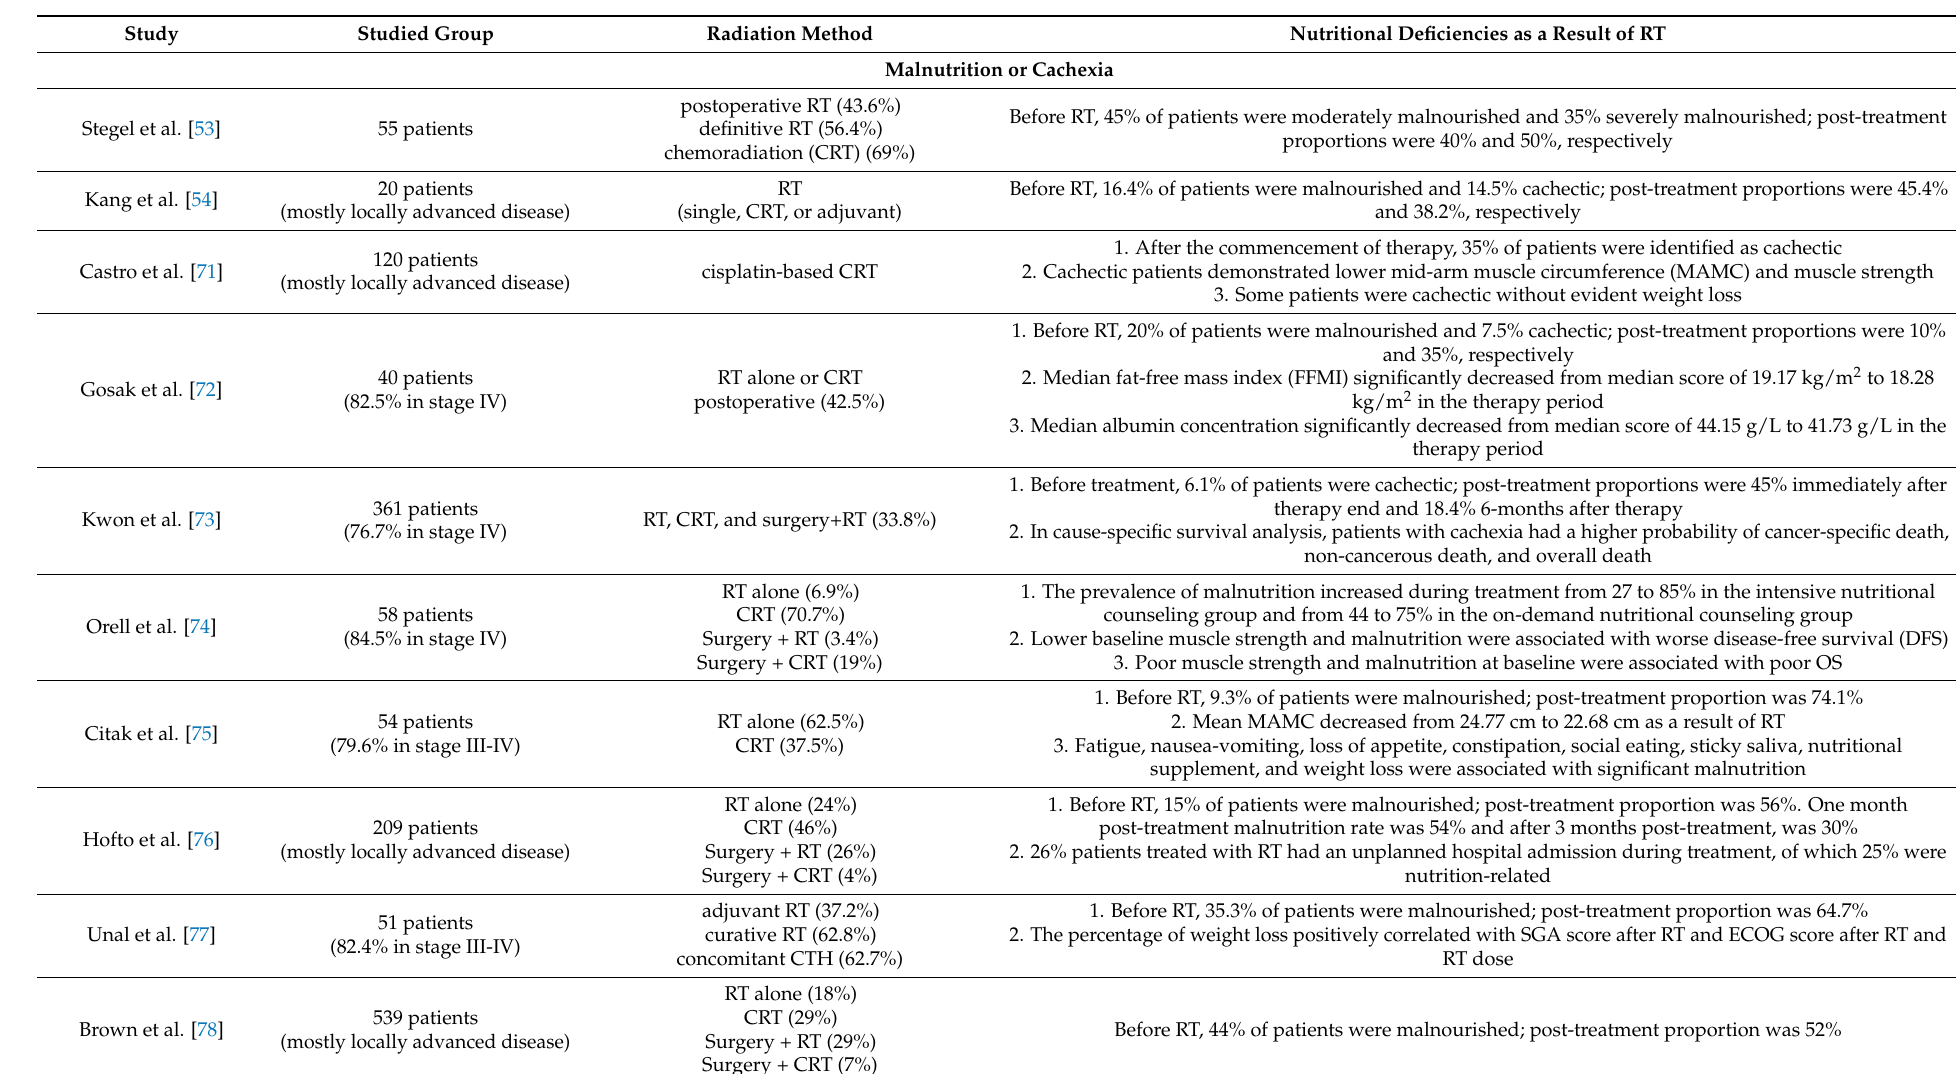
Table 2. Nutritional deficiencies developing after RT intervention in HNC patients recorded throughout clinical